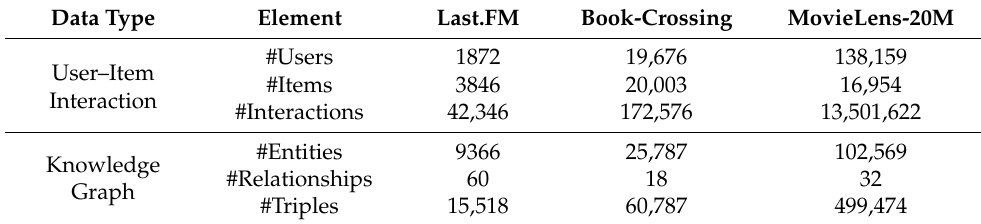
Table 1. Detailed statistics of the three datasets (# means ‘the number